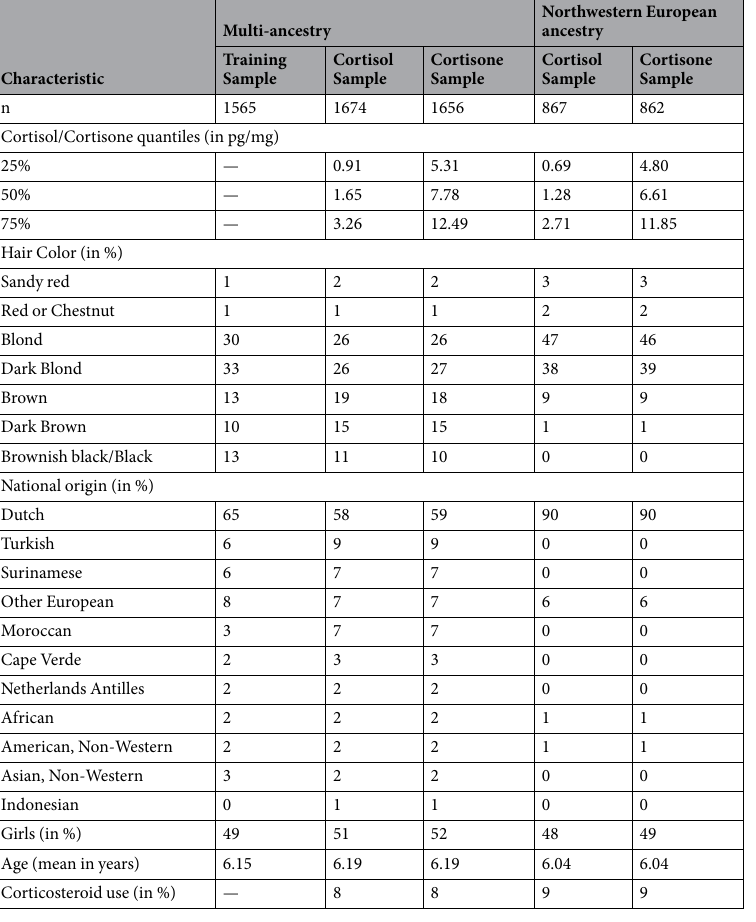
Table 1. Participant